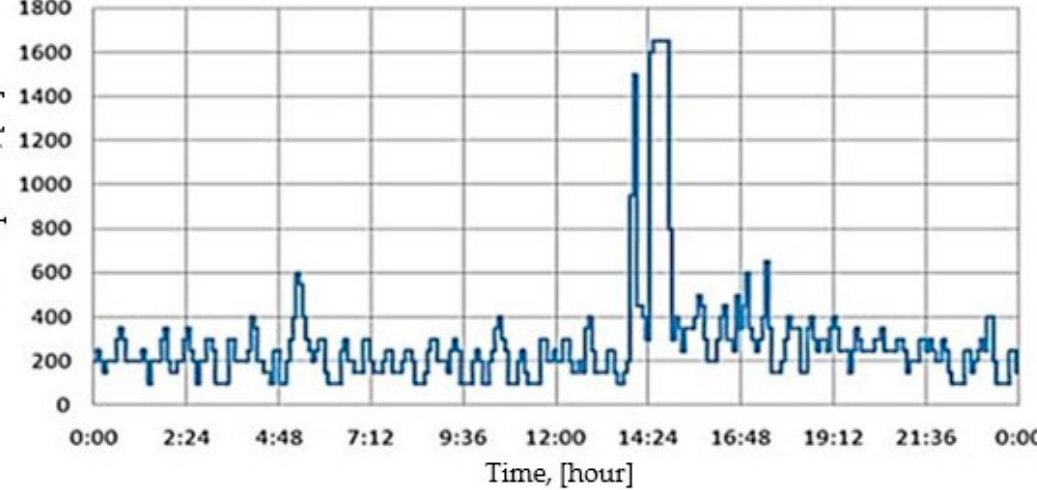
Figure 5. Daily load curve recorded for the household consumer with the active power values in 50 W steps.